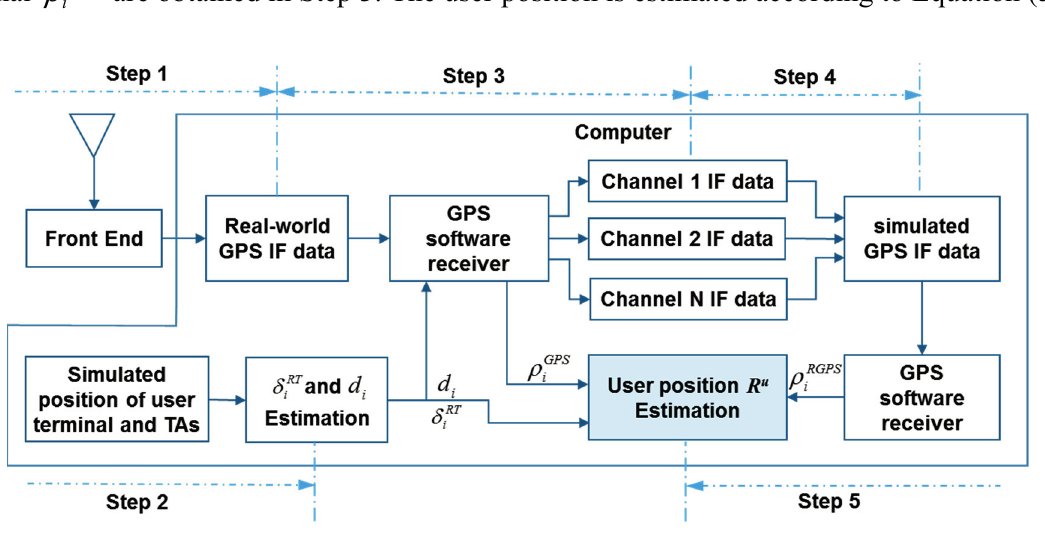
Figure 5. Simulation process.